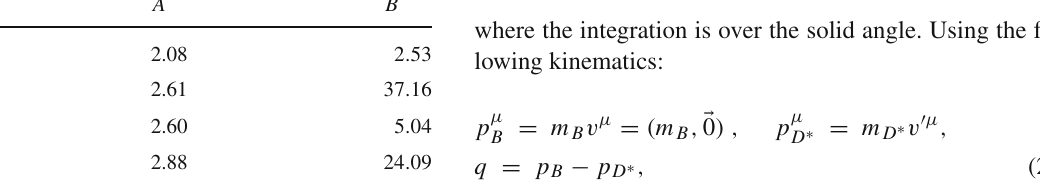
the amplitude for the decay B → D s D ∗ is computed